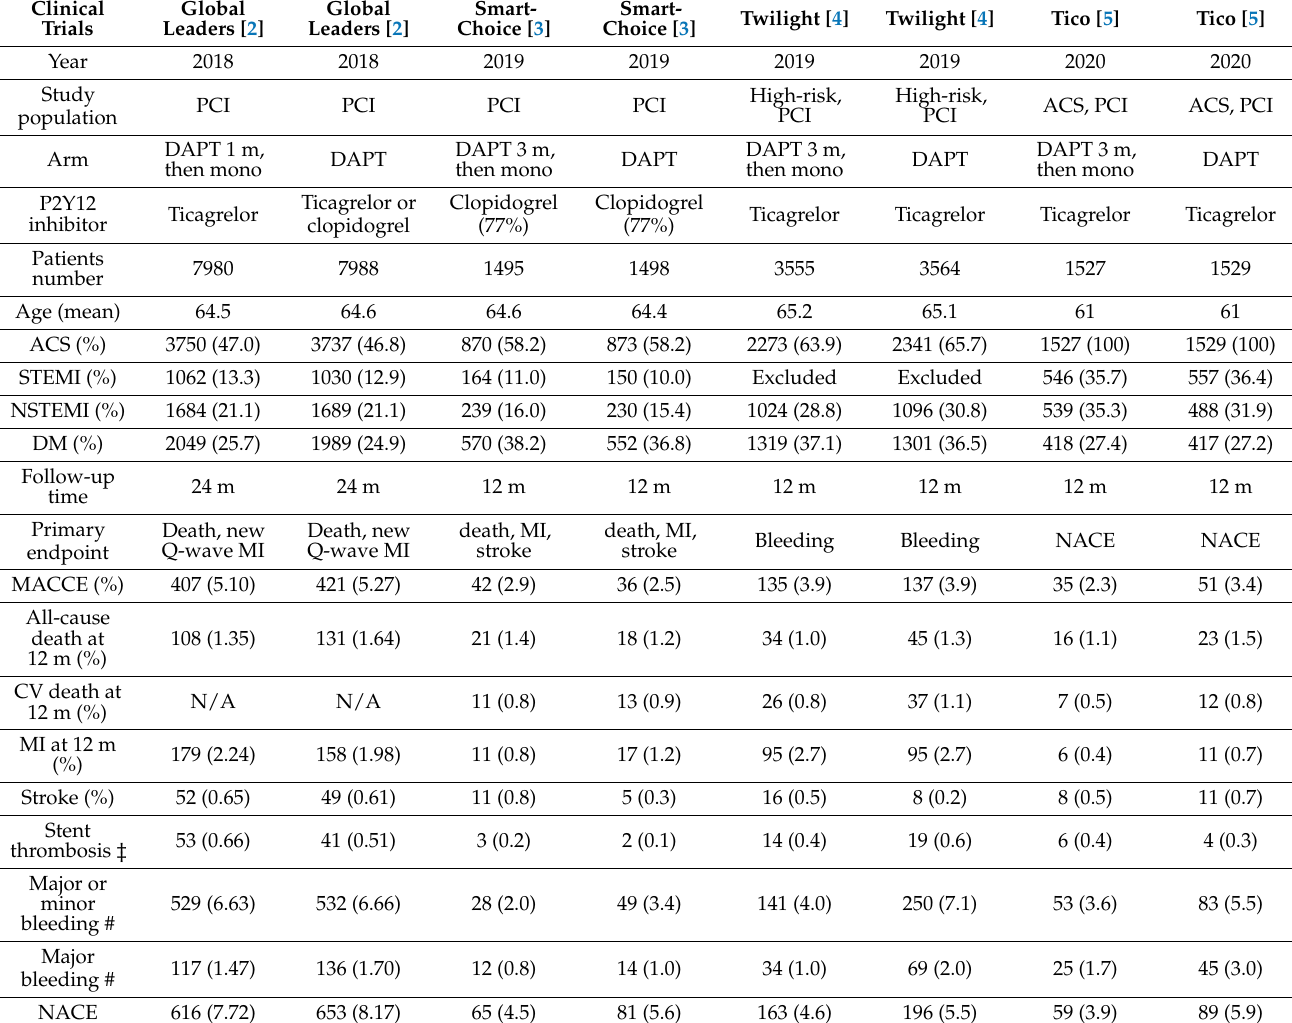
Table 1. Clinical characteristics and outcomes of included randomized